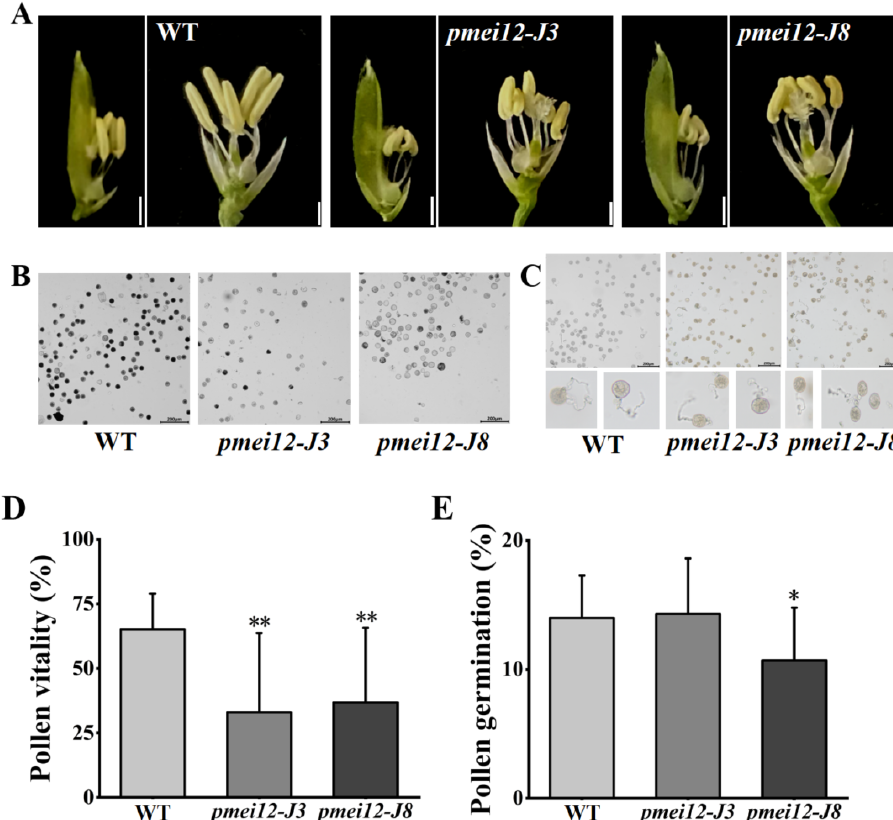
Figure 5. Pollen fertility of WT and pmei12 lines. ( A ) Anthers of the spike in middle; ( B ) Pollen activity; ( C ) Pollen tube growth of rice; ( D ) Pollen vitality ( E ) Pollen germination. * and ** indicate the significant difference between pmei12 lines and WT by t -test at p < 0.05 and 0.01, respectively. Scale bars: ( A ) 2 mm; ( B , C ) 200 µ m (n = 50).